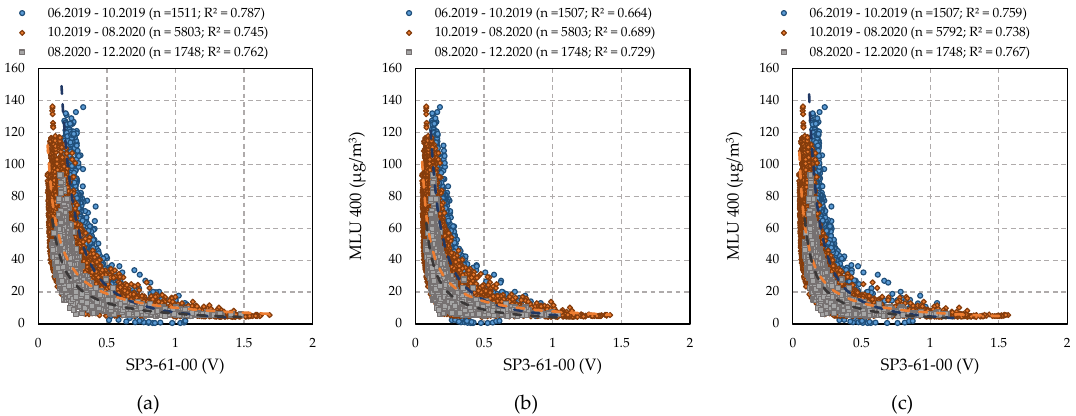
Figure 6. Results of power-law fittings for 1 h averaged data from SP3-61-00: ( a ) unit No. 1; ( b ) unit No. 2; ( c ) unit No. 3. Dashed lines denote the fitted curves. n—number of samples used for the fitting, R 2 —coefficient of determination.